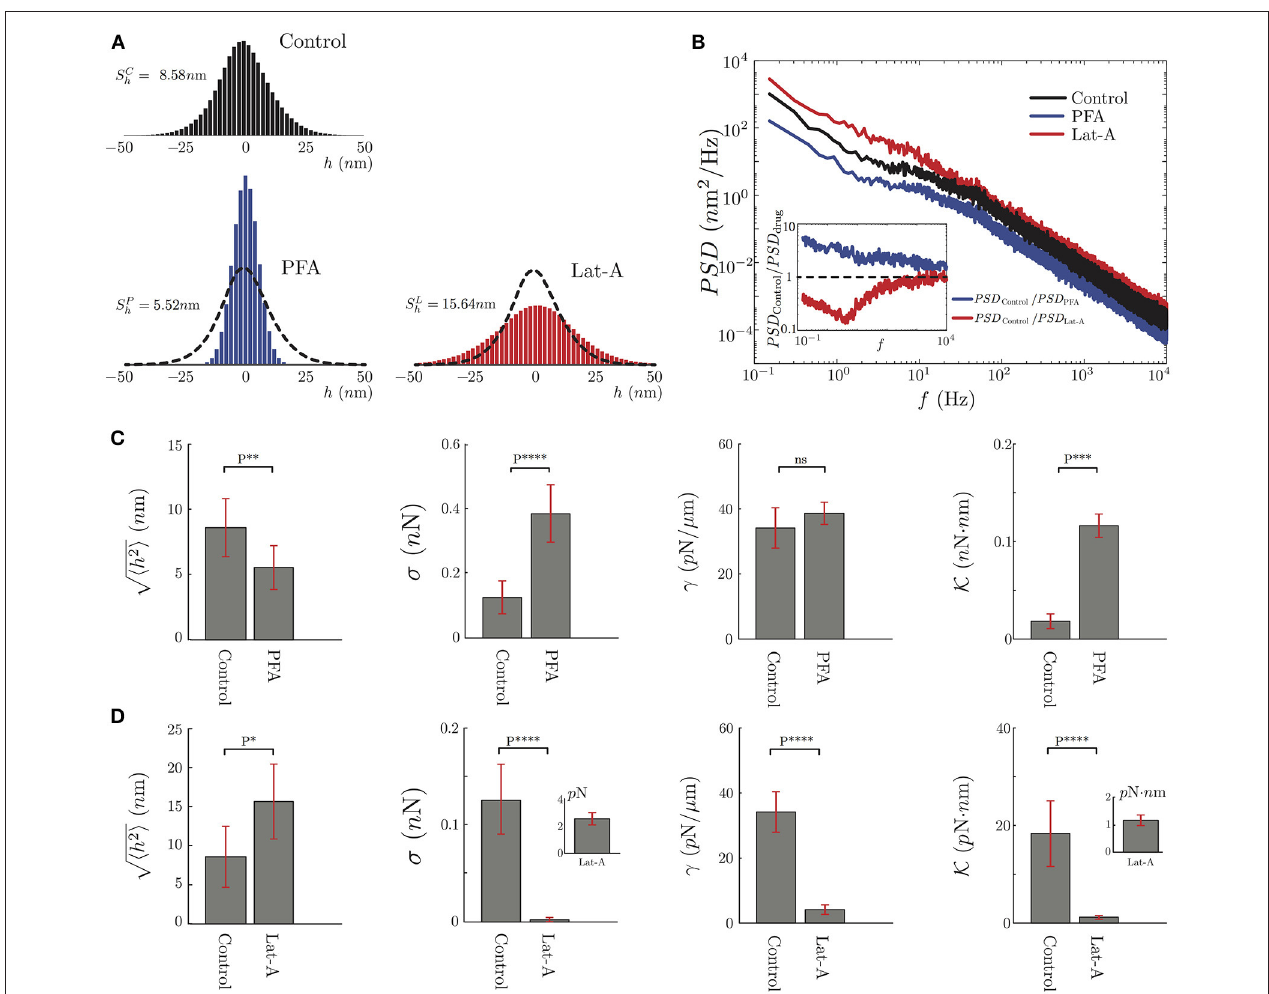
FIGURE 6 | Mechanical characterization of PC12 neurites under effects of PFA and Lat-A. (A) The average amplitude fluctuation distribution of the seven plus seven control neurites ( N = 14), and the same seven neurites under PFA ( N = 7) or Lat-A ( N = 7). (B) Average PSD of the Control, PFA and Lat-A PC12 neurites groups. The inset displays the ratio of the averaged altered PSD taking as a reference the average control PSD . (C,D) Quantification of the PFA and Lat-A, respectively, effects in the PC12 neurite mechanical parameters: axial tension σ , plasma membrane tension γ , plasma membrane bending rigidity K